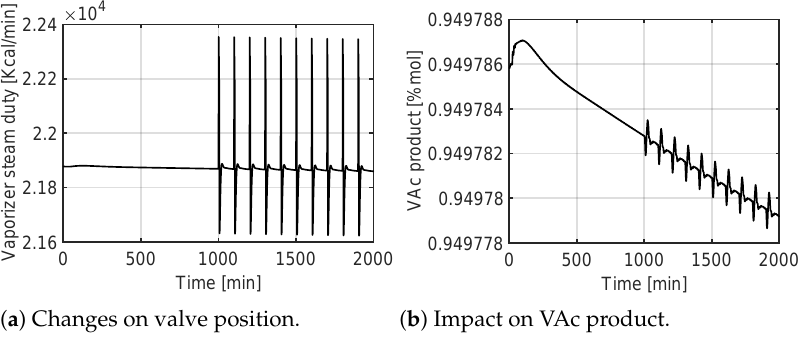
Figure 15. APT example: repeated pulses on the vaporizer steam duty valve (control variable #4).